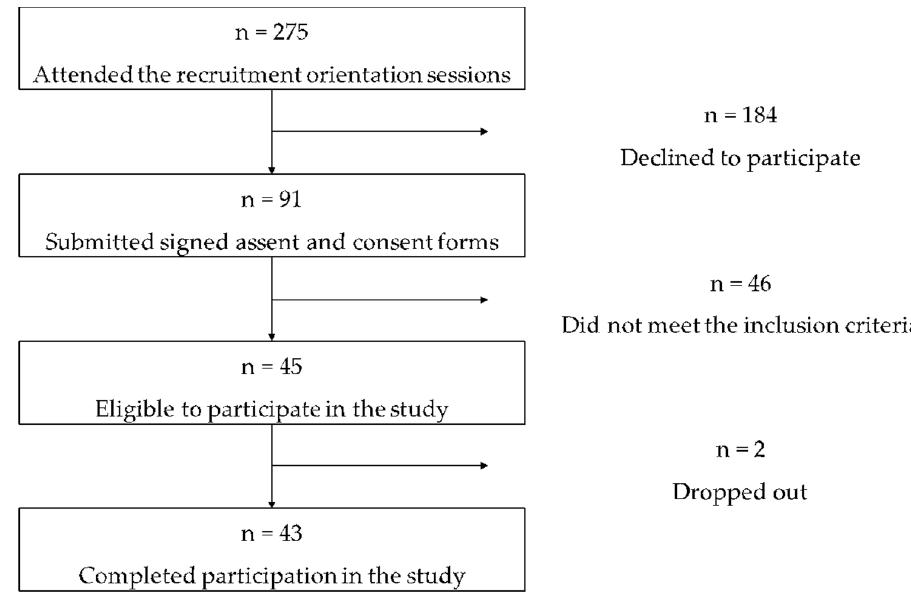
Figure 1. Flow diagram for recruitment, screening, selection, and retention of study participants.